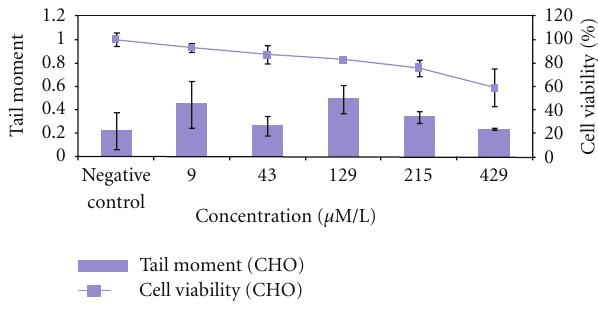
Figure 9: Genotoxicity of Me 4 Sn in CHO-9 cells after 1h exposure time measured by Comet-Assay. The tests were repeated three